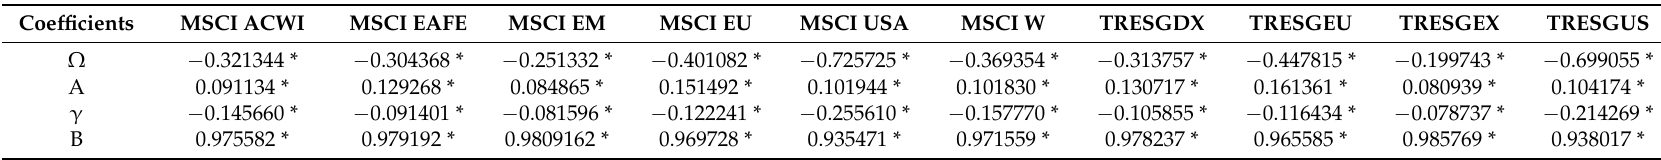
Table 2. Auto-regressive conditional heteroskedasticity (ARCH) and GARCH Coefficients for the sustainable and conventional market indices.